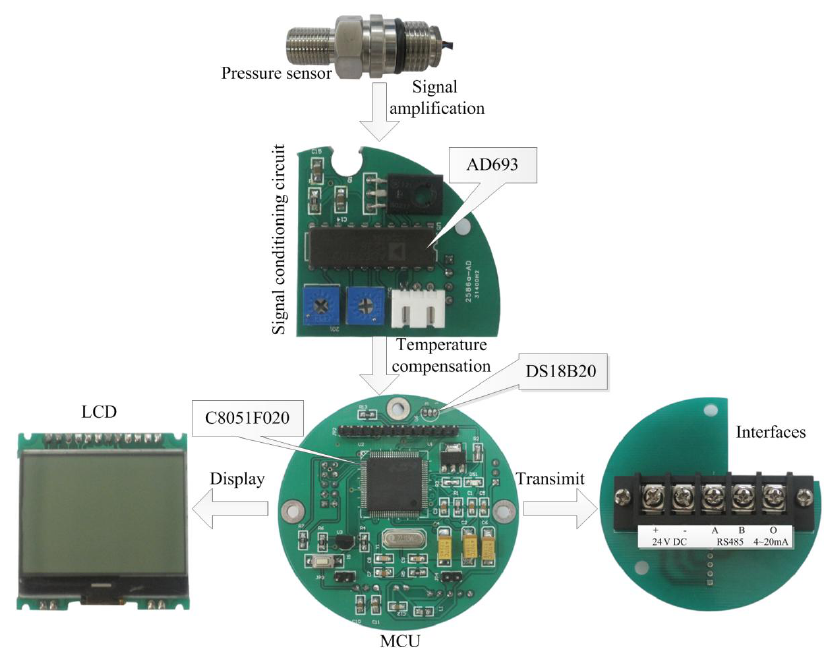
Figure 5. Hardware components of system.